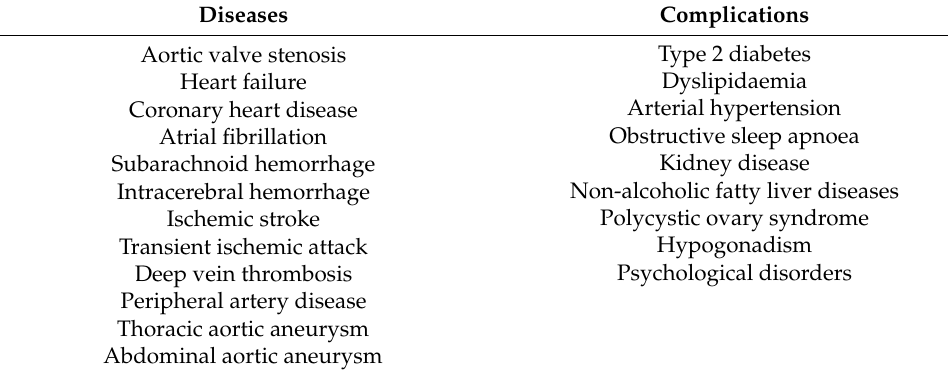
Table 1. Comorbidities associated with